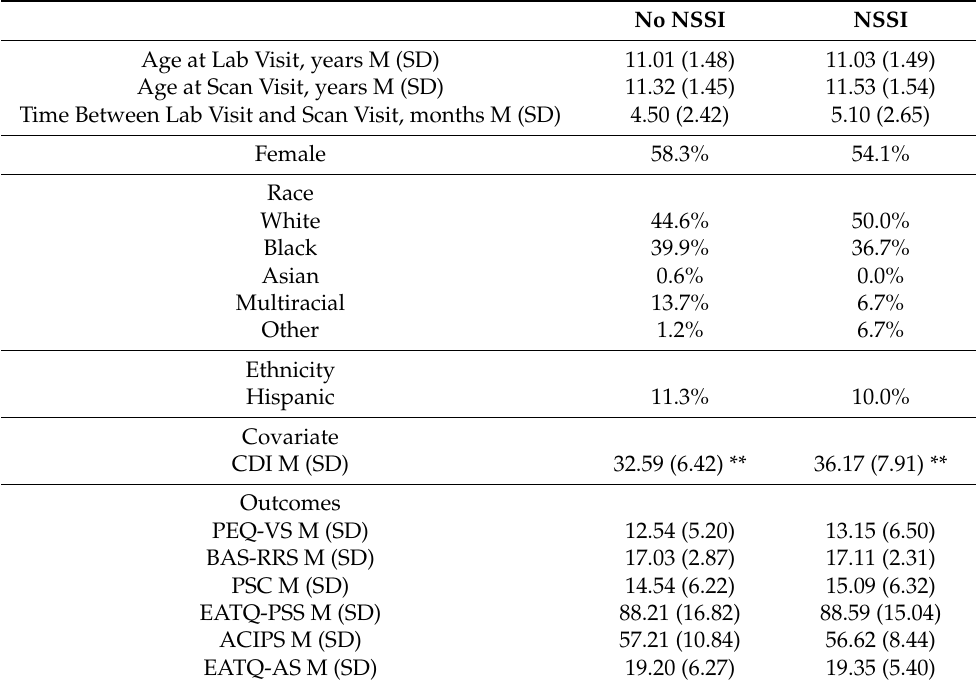
Table 1. Demographic and clinical characteristics in youth engaging and not engaging in NSSI.